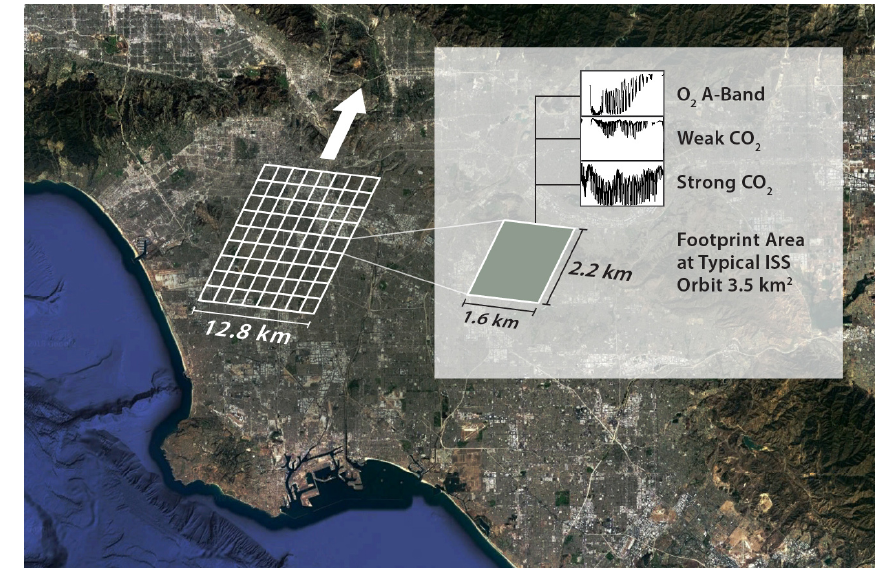
Figure 1. OCO-3 context image depicting nine sequential frames acquired in 3.0s in nadir-viewing mode over the Los Angeles basin. Each frame contains eight adjacent footprints in the cross-track direction with a size of 2.2km by 1.6km, yielding a footprint area of approximately 3.5km 2 . Each footprint constitutes a sounding, containing high-resolution spectra in the oxygen A, weak CO 2 , and strong CO 2 bands. Image courtesy of Karen Yuen and Laura Generosa at